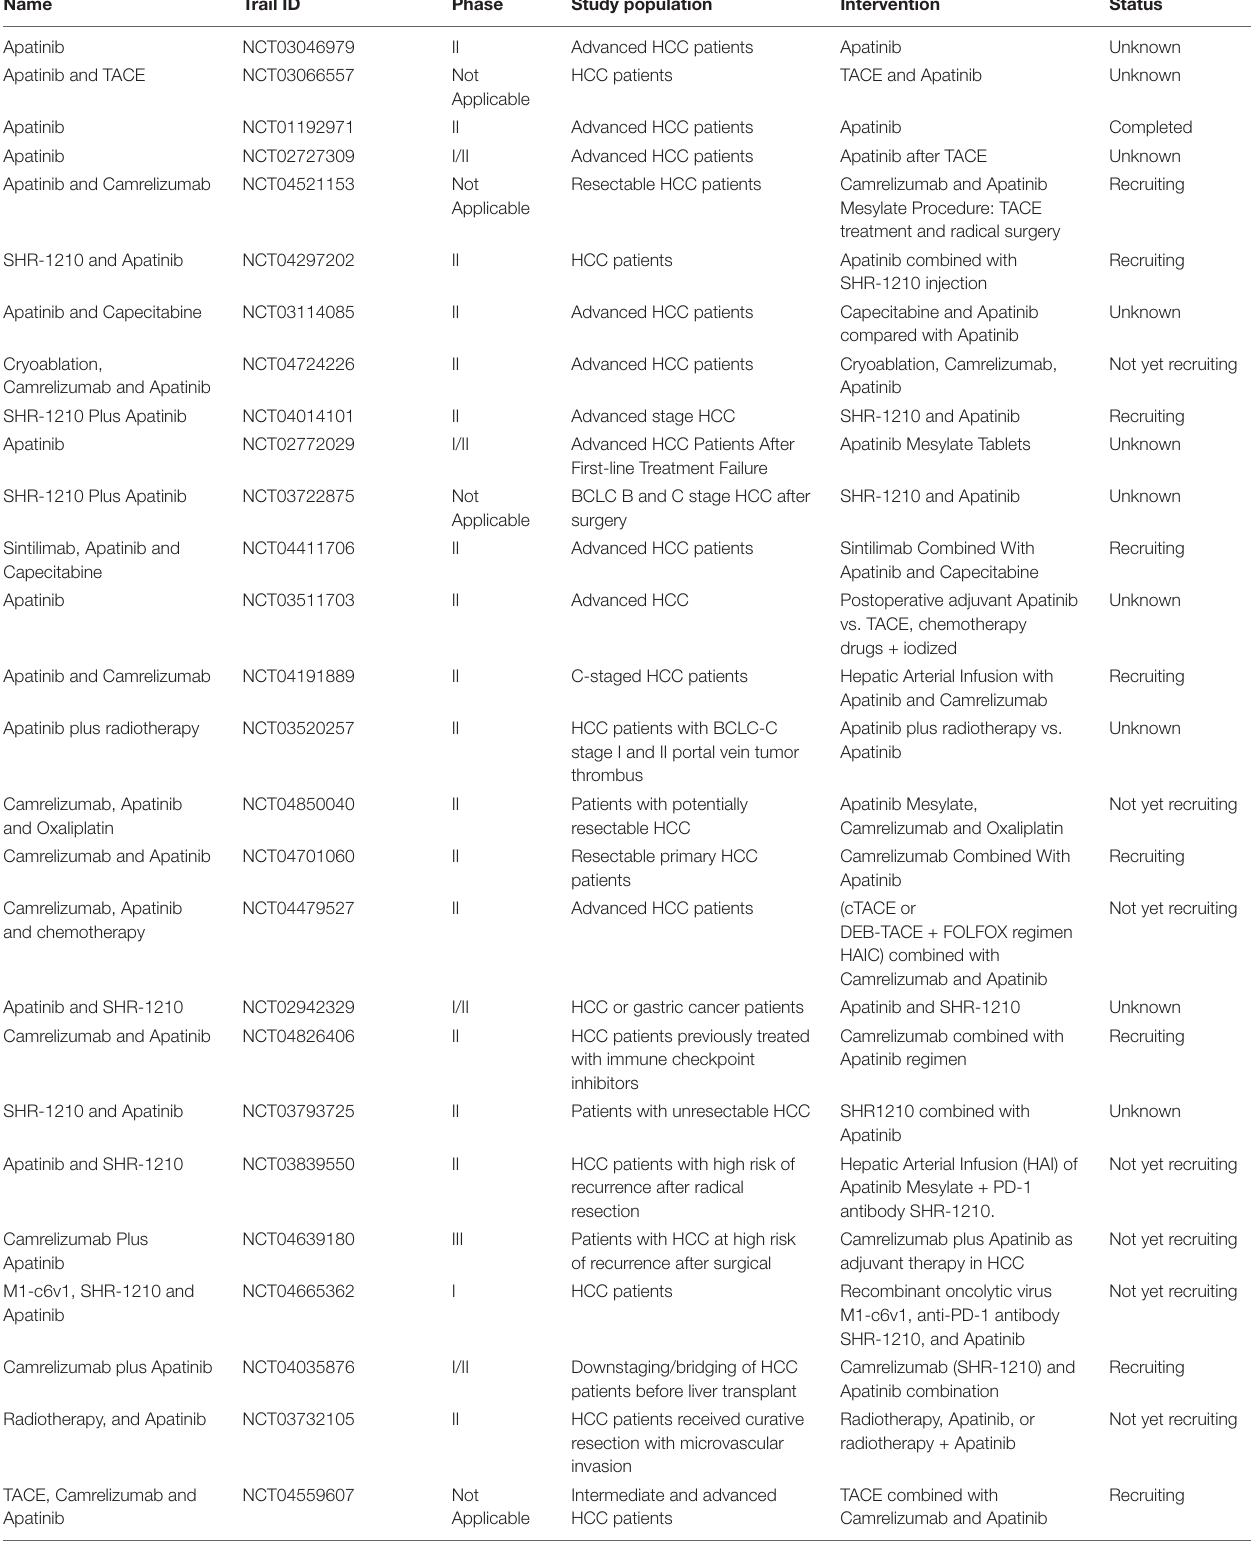
TABLE 3 | Ongoing clinical trials involving Apatinib (VEGFR2 inhibitor) in